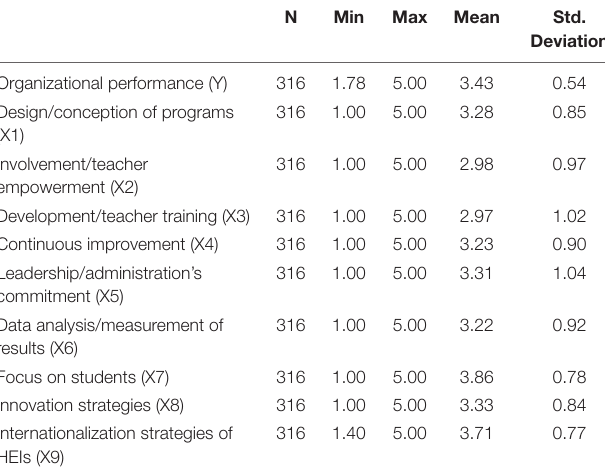
TABLE 2 | Descriptive statistics of the variables under